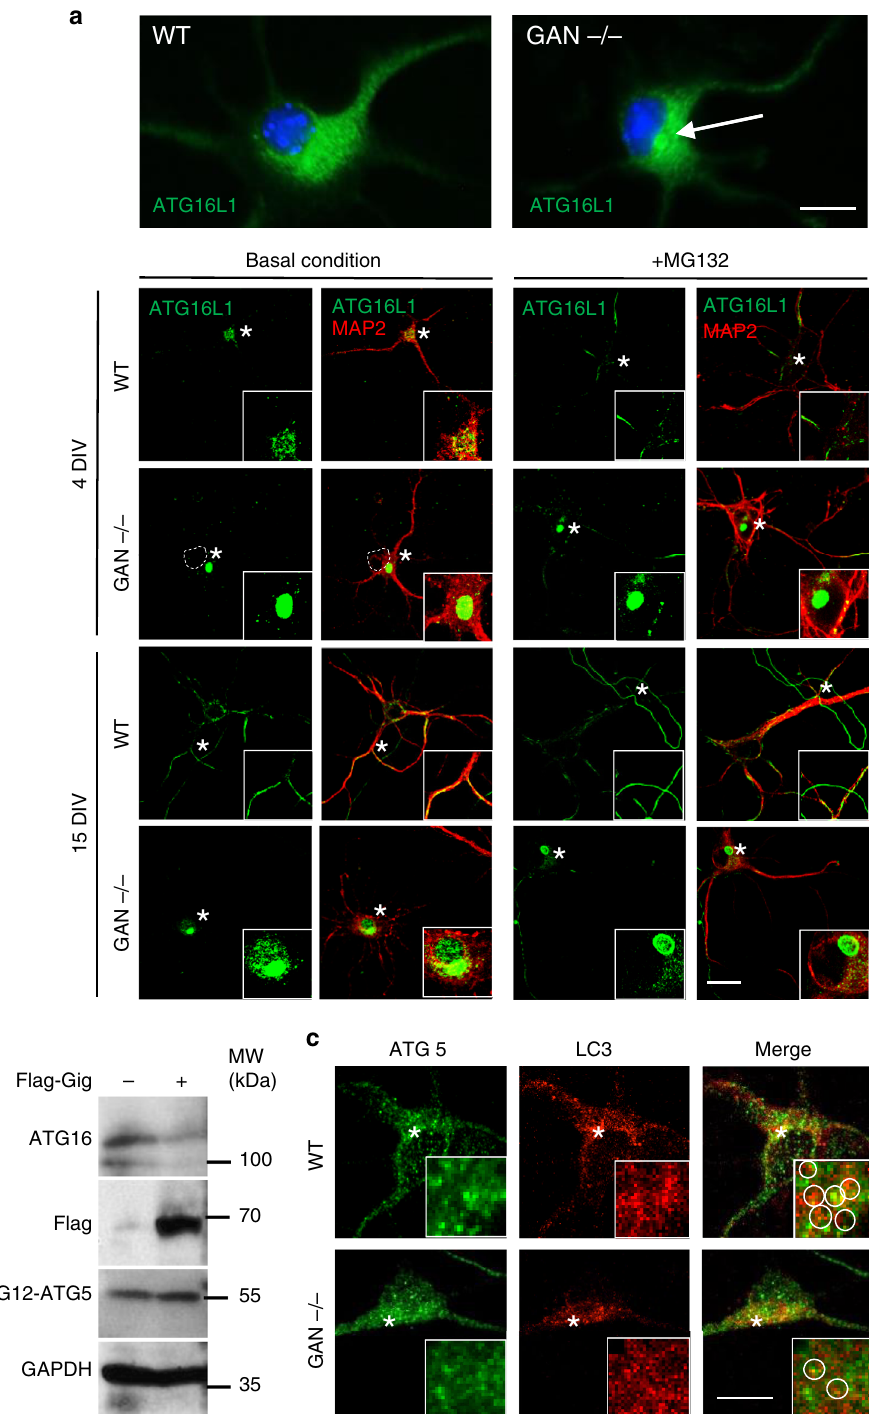
Fig. 4 ATG16L1 accumulates in GAN -/- cortical neurons and impairs the autophagy elongation conjugate. a MAP2 positive neurons, prepared from cortices of E15.5 GAN embryos were immunostained with ATG16L1 antibody after 4 and 15 div (days in vitro) ± proteasome inhibitor. Top panel shows an enlarge picture of the single perinuclear bundle of ATG16L1 found in the soma of GAN -/- cells. Dashed line shows the nucleus. Scale bar: 10 µ m for upper panel and 20 µ m for bottom panel. b The effect of Gigaxonin in the conjugation of ATG12-ATG5 was evidenced in COS-7 cells. Transfected Flag-Gigaxonin degraded endogenous ATG16L1 but did not alter the formation of ATG12-ATG5 elongation complex, which migrates at 55 kDa. c ATG5 does not aggregate in Gigaxonin-null neurons. The visualisation of the docking of endogenous ATG5 to autophagosomes was hampered by the high density of LC3 dots in cortical neurons, but would reveal a decreased density around autophagic structures in the GAN -/- neurons (inserts: circles drawn to highlight LC3-ATG5 proximity in individual dots). Scale bar: 10 µ